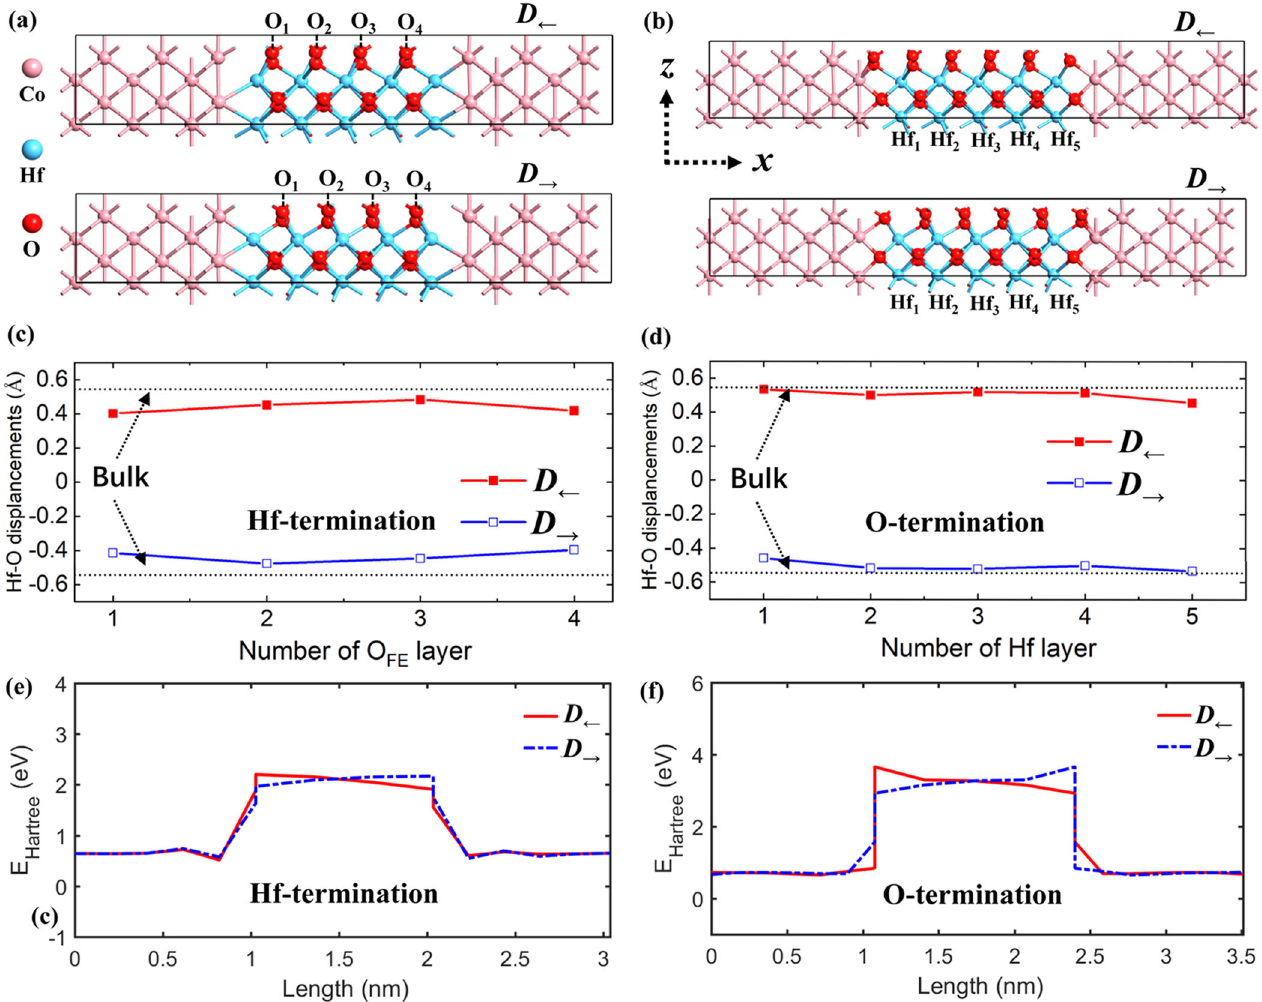
Fig. 2 Atomistic structures, Hf-O displacements and Hartree potential energies of Co/HfO 2 /Co junctions. Atomistic structures of Co/HfO 2 / Co junctions in an antiparallel state with symmetric interfaces terminated by ( a ) Hf and ( b ) O atoms. The oxygen layers (O FE ) responsible for the ferroelectricity are indicated in a . The Hf-O displacements across HfO 2 layers: ( c ) Hf-termination and ( d ) O-termination. The Hf-O displacement is calculated as the difference between the O FE /Hf coordinates along the x axis and the averaged x coordinate of the two adjacent Hf/O FE layers in the Hf/O-terminated case. The dashed line indicates the Hf-O displacement in bulk Pca2 1 HfO 2 . The calculated Hartree potential energies of Co/HfO 2 /Co junctions averaged in atomistic layers for D ← and D → oxygen displacements: ( e ) Hf-terminated and ( f ) O-terminated